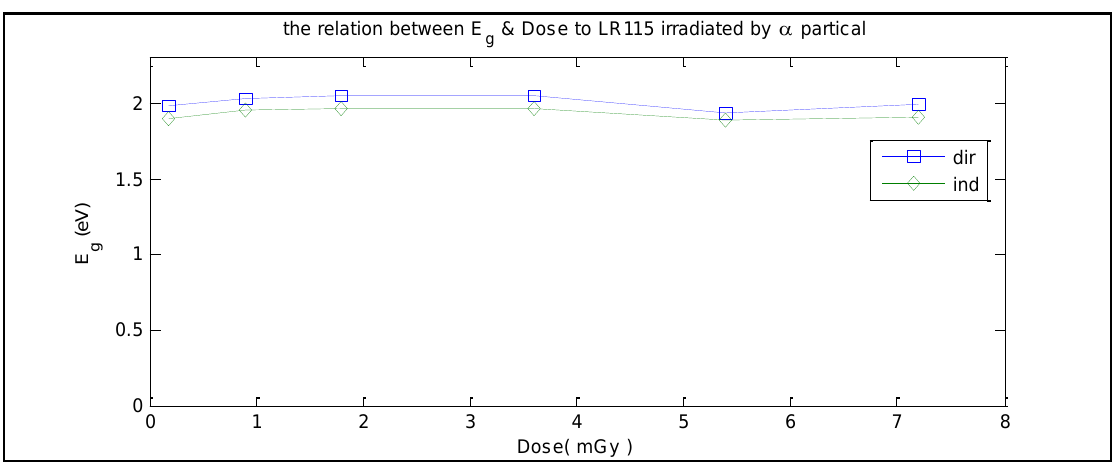
Fig.5: Plots for transition energy (eV) as a function of alpha absorbed dose (mGy ).